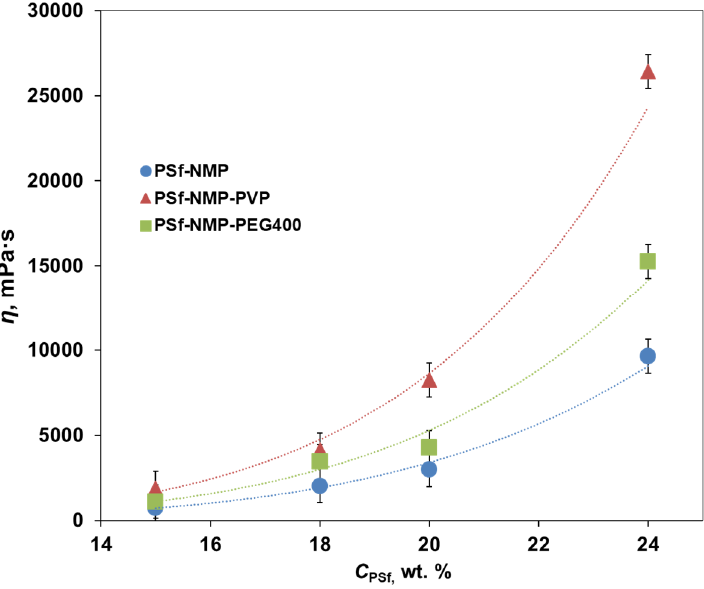
Figure 3. Dynamic viscosity of PSf in N-methylpyrrolidone (NMP) casting solutions. I—PSf-NMP; II—PSf-NMP-PVP; III—PSf-NMP-PEG.